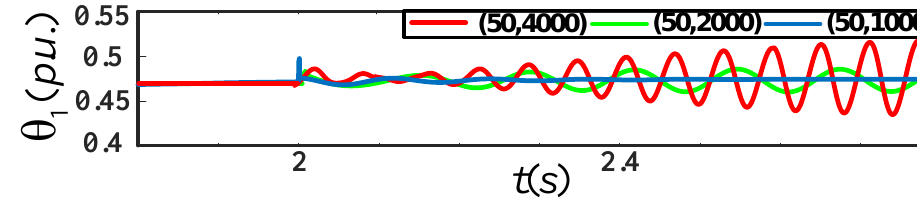
Figure 11. Time domain responses of θ of WT 1 with different control parameters of PLL ( k I 23 ) of WT